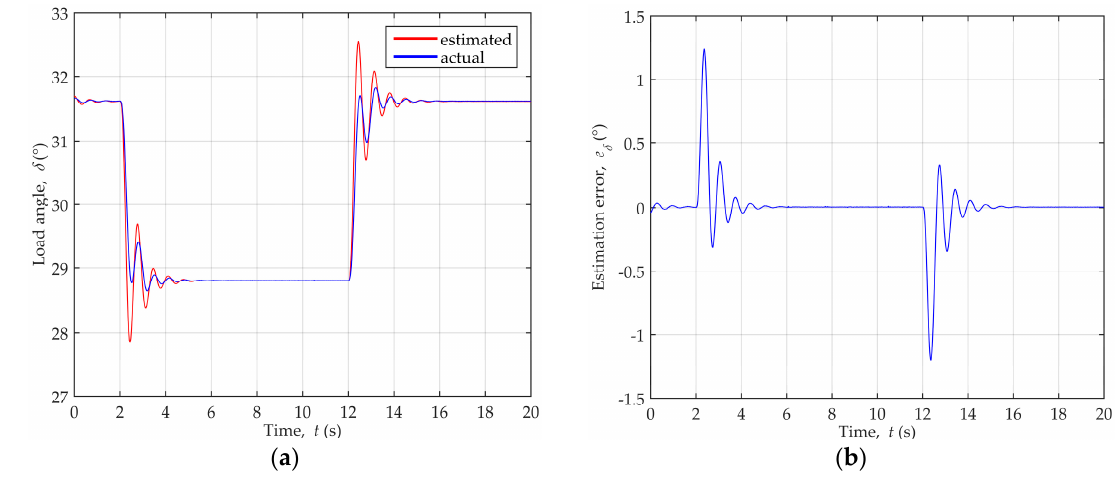
Figure 17. Load angle variation during dynamic disturbances of active power for generator operating point P = 0.89, Q = 0: ( a ) Comparison of the actual and estimated load angle values; ( b ) Load angle estimation error.